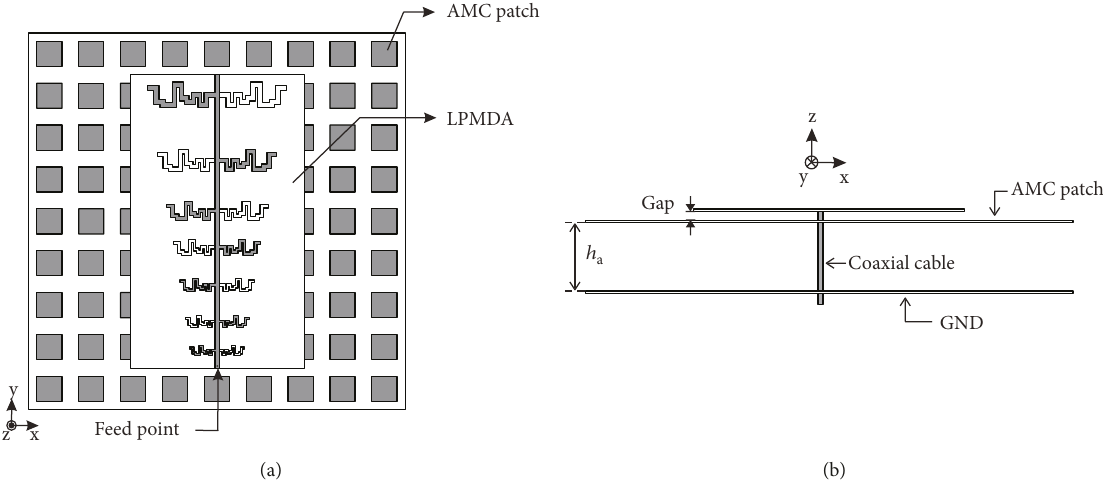
xy z Feed point Figure 10: Geometry of the proposed antenna with the AMC: (a) top view and (b) side